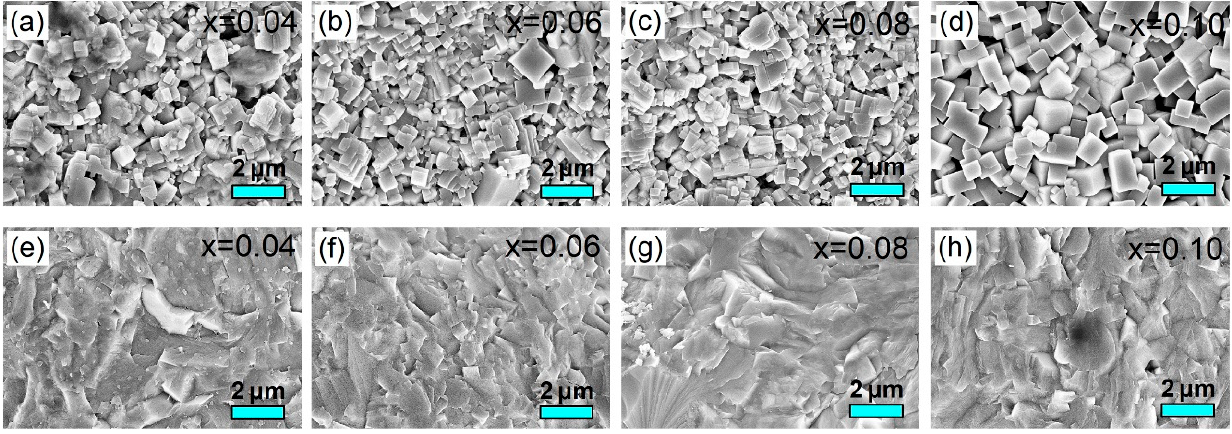
Figure 2. ( a – d ) Surface and ( e – h ) cross-sectional FE-SEM images of KNNS x -BNN ceramics.